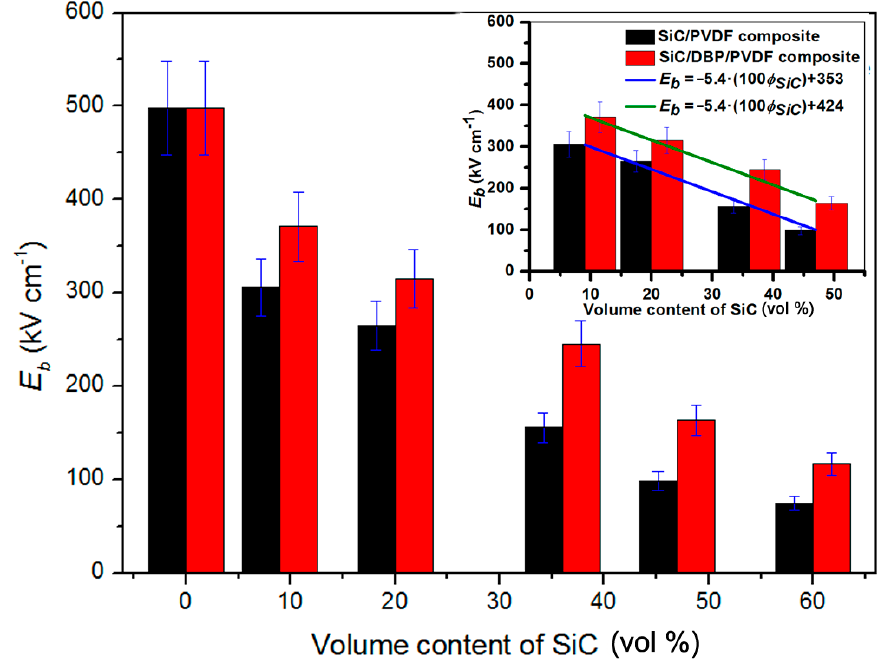
Figure 4. Breakdown strengths show the higher values for the ternary composites than for the corresponding binary composites, with the increase of SiC volume content; the inset shows the slope of two fitted straight lines and the difference between the intercepts of both composite systems from the DBP plasticizer.